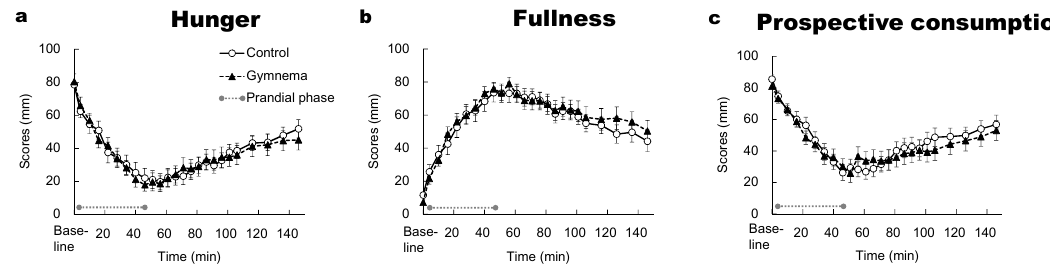
Figure 5. Time courses of hunger ( a ), fullness ( b ) and prospective consumption ( c ) during and after consuming sweet-tasting foods. Mean ± SE. Grey circles at both ends of the dotted gray line denote the limits of the prandial phase (consumption of sweet-tasting food).